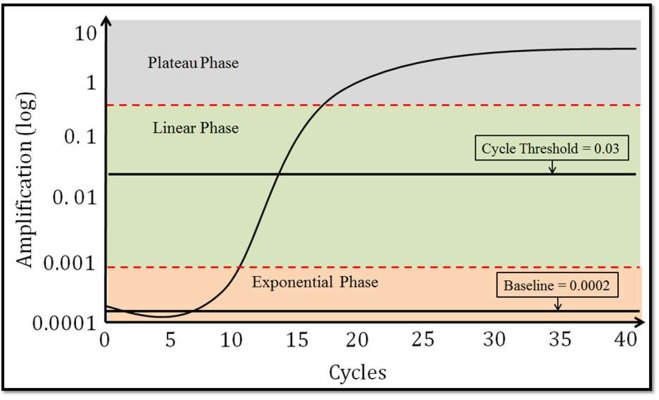
The phases and components of a PCR curves: (1) baseline, (2) exponential phase, (3) linear phase, (4) plateau phase, and (5) cycle threshold.